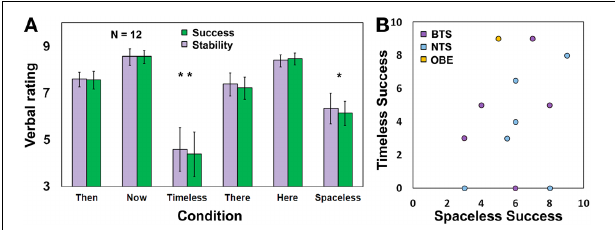
FIGURE 2 | Rating of task success and stability. (A) Participants’ rating (Mean ± s.e.m., n = 12) for success and stability during the different conditions. ∗ p < 0 . 05, ∗∗ p < 0 . 005, Bonferonni-corrected; (B) A scatterplot for the Timelessness vs. Spacelessness rated success. BTS, Both time and space; NTS, Not both Time and Space. Yellow dot refers to one OBE